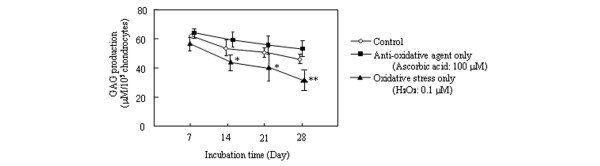
Glycosaminoglycan (GAG) production from cultured chondrocytes under different oxidative conditions. After the incubation times indicated, in the presence of 0.1 μmol/l H2O2 or 100.0 μmol/l ascorbic acid (initial subculture at the start of the experiment: 1 × 105 cells/dish, chondrocytes at passage 2), chondrocytes were collected and transferred to a new culture dish (1 × 105 cells/dish). Following 12 hours of incubation, the amount of GAG in the supernatant was measured using a spectrophotometric assay with dimethylmethylene blue. Values are expressed as the mean ± standard deviation of nine donors (n = 4 culture dishes per treatment group at each incubation period; *P < 0.05, **P < 0.01, versus control group at each incubation time). The H2O2 treated group exhibited a significant decrease in GAG production by chondrocytes as compared with the control group at all incubation times. In the antioxidative agent group the level of proteoglycan production tended to increase as compared with the control group, although no significant differences were observed between the control groups and antioxidative agent groups at any incubation time.